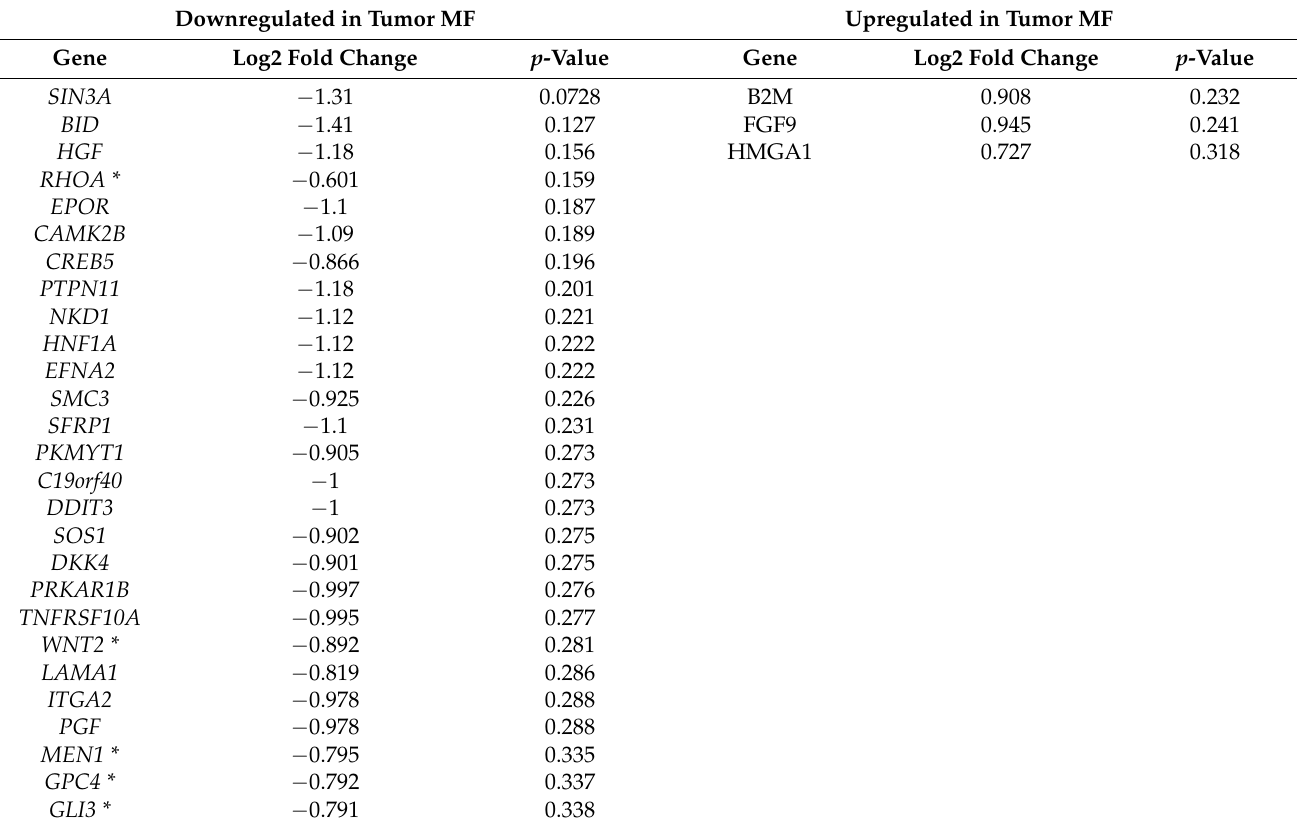
Table 3. Differential expression analysis revealed the 30 gene targets with the highest statistically significant upregulated (3 genes) or downregulated (27 genes) gene expression in tumor MF groups compared to non-tumor MF groups. These 30 gene targets substantially overlap with the top upregulated and downregulated genes identified using the tumor/non- tumor MF ratios, with 25 of these 30 genes being listed in Table 1 or Table